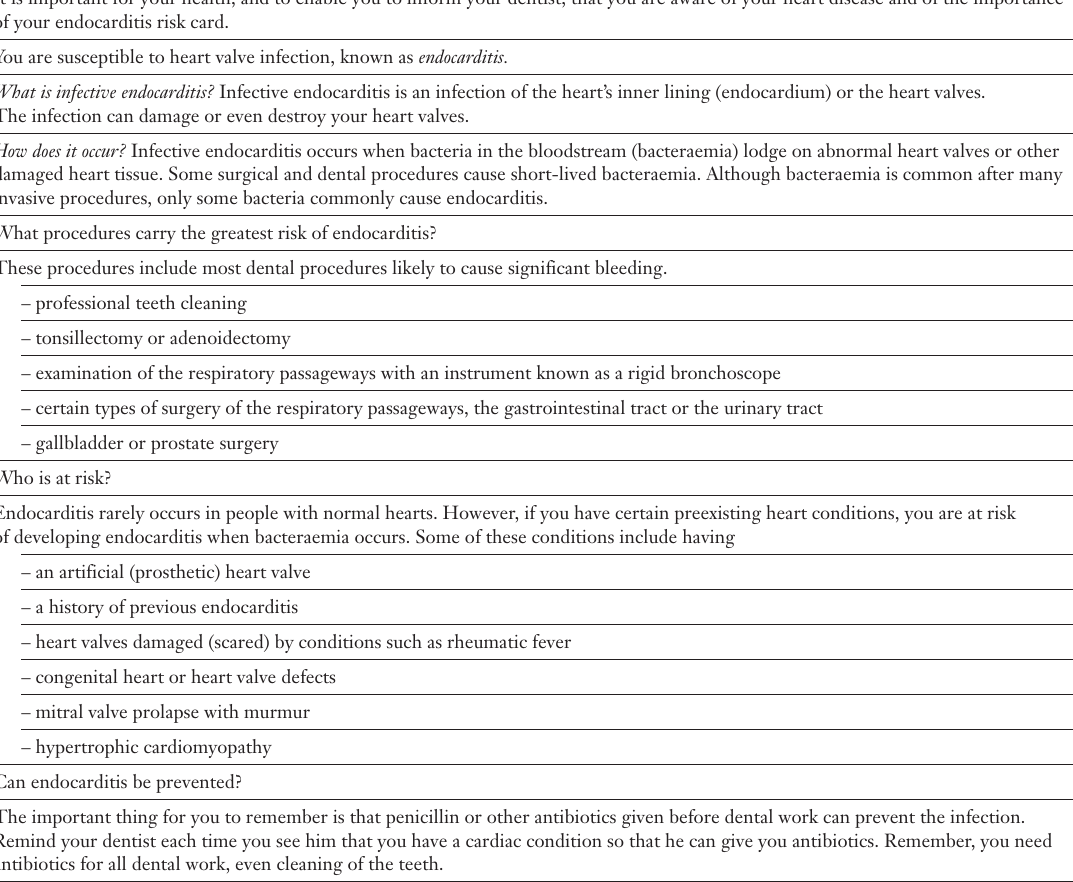
Retraining protocol on infective endo- carditis, prophylaxis of infective endo- carditis and hygiene measures.